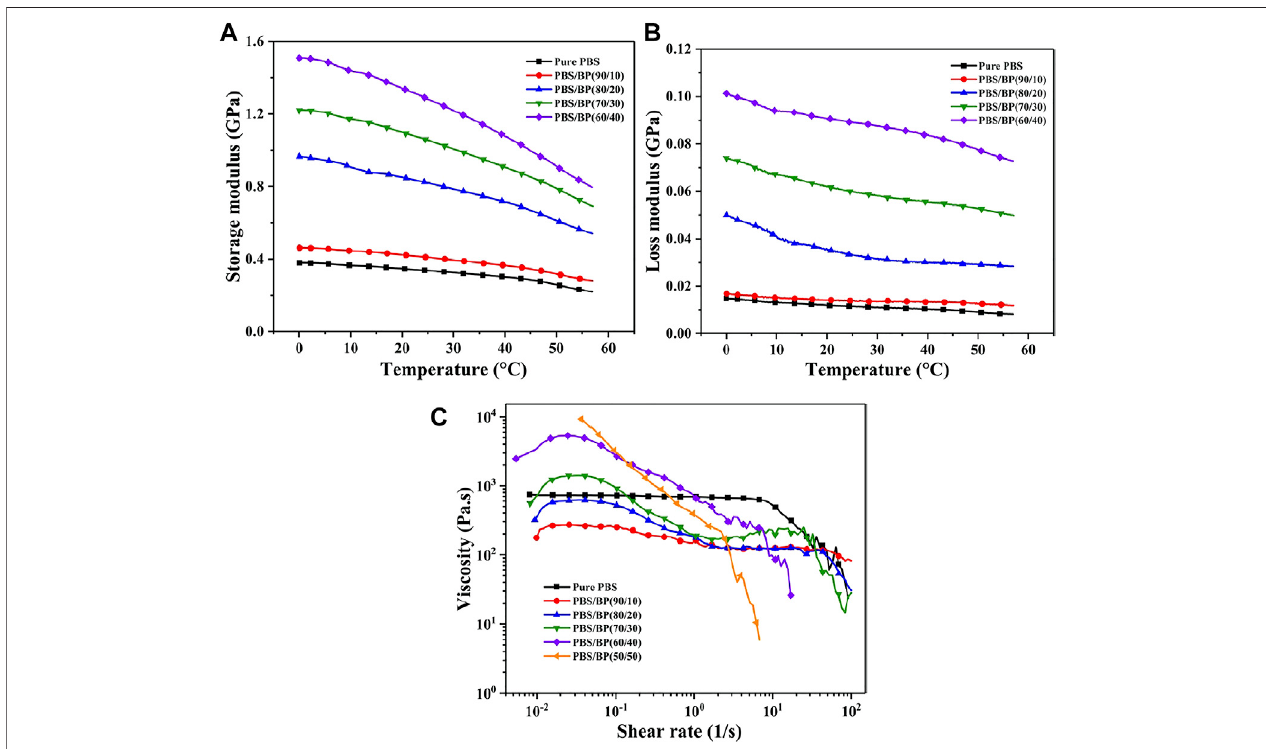
FIGURE 6 | Variations of (A) storage modulus; (B) loss modulus; and (C) viscosity with temperature for pure PBS and PBS/BP blends at varied